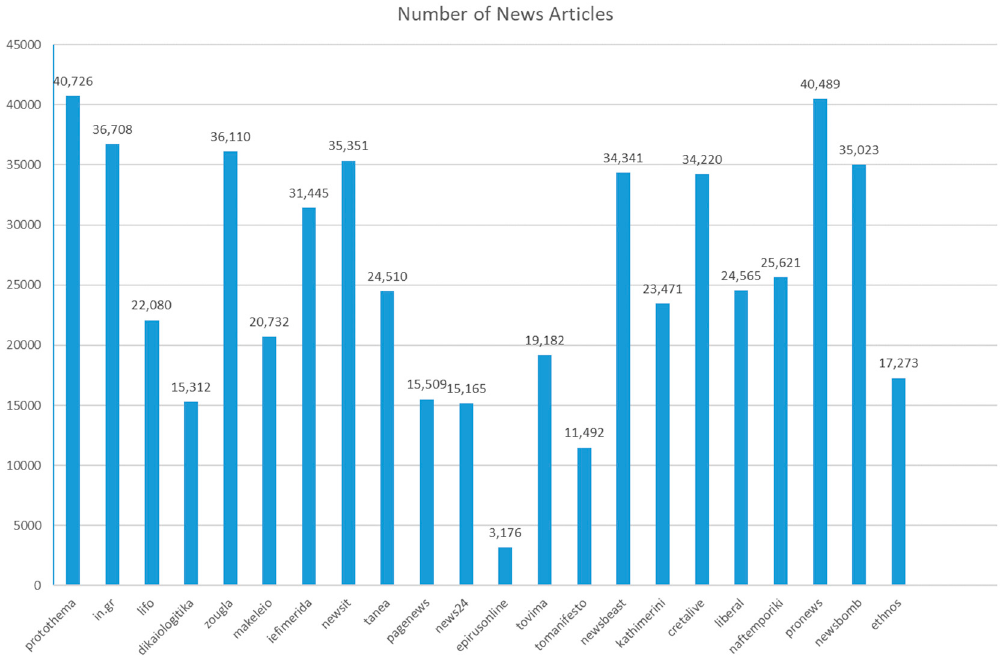
Figure 10. Total number of articles per media organization. Media organizations are displayed based on the Alexa rank- ing—leftmost being the highest and rightmost the lowest traffic.